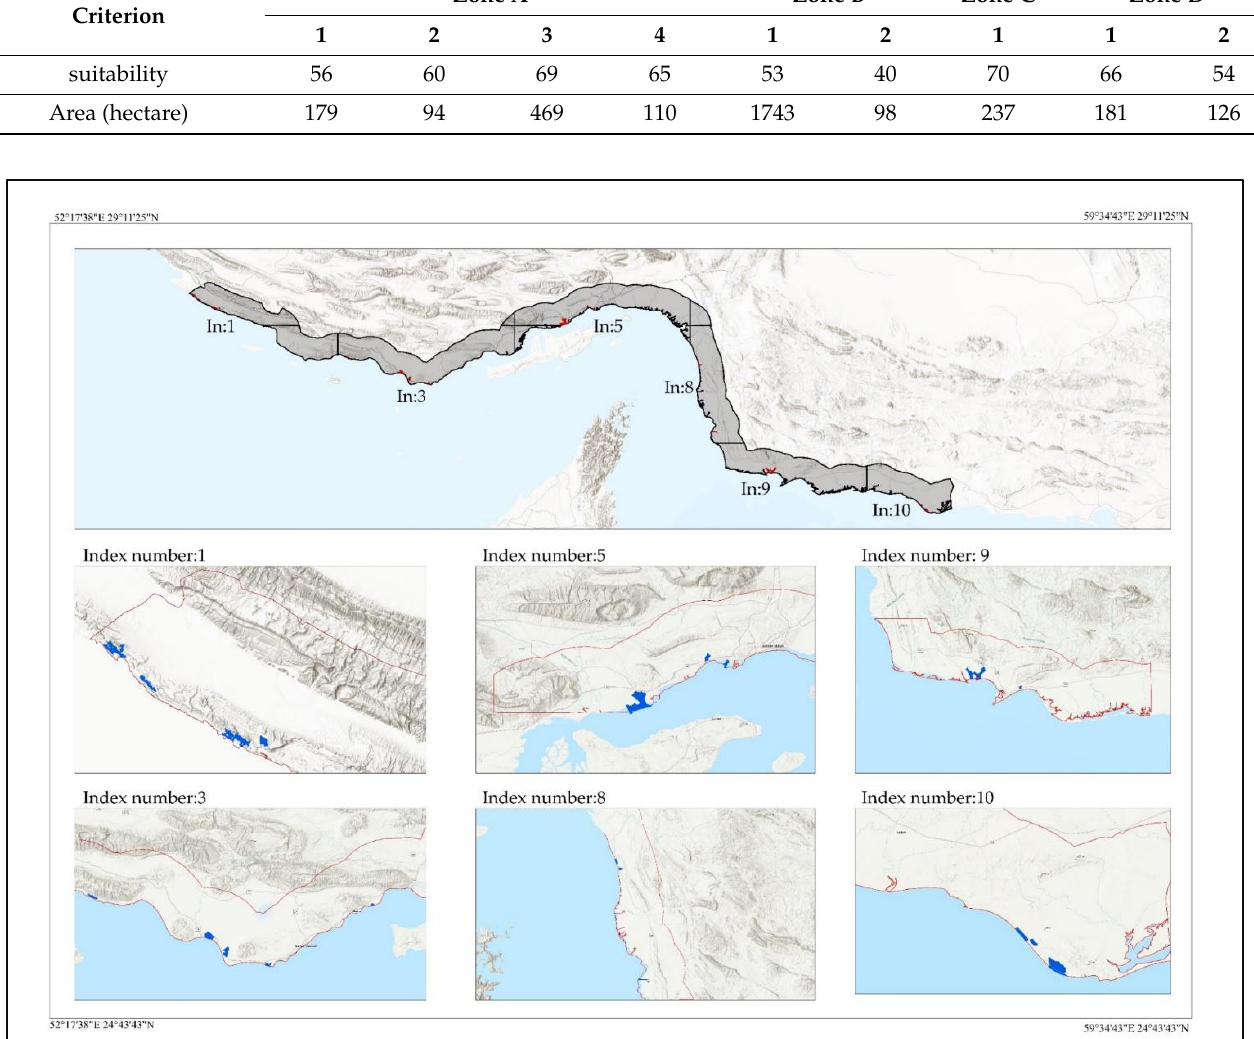
Table 4. The average suitability of the criteria in the eastern part of region.